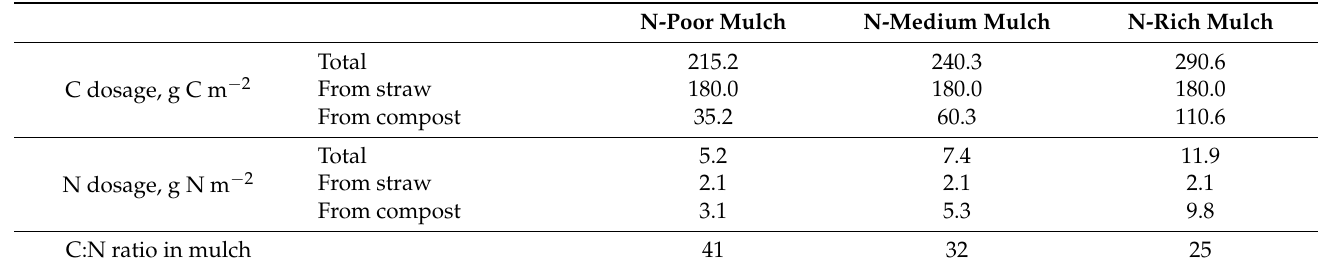
Table 1. Dosages of C and N from straw and compost used in the experiment. N-Poor